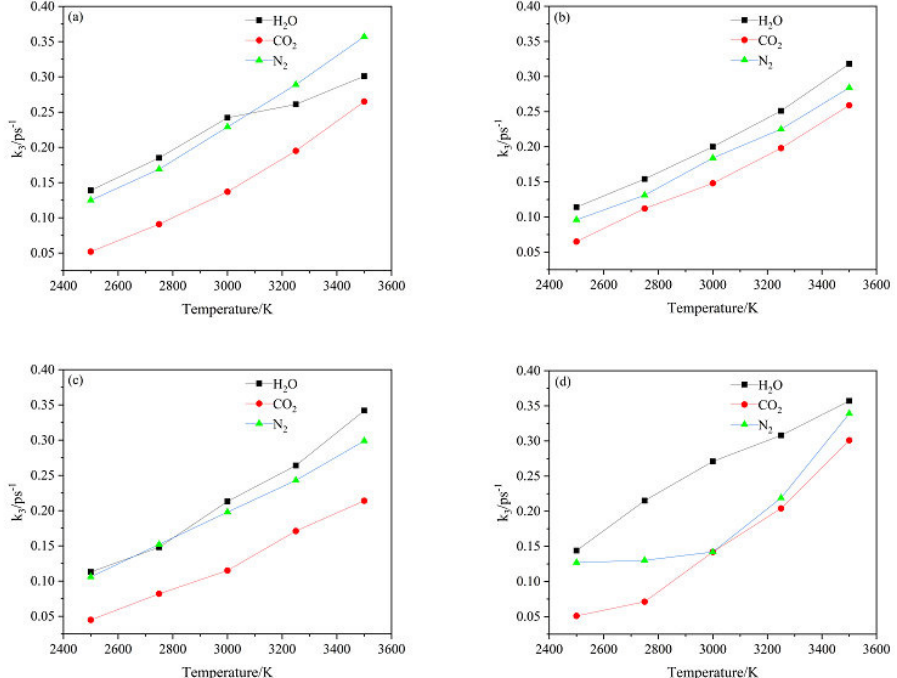
Figure 14. Comparison of the k 3 values of CO 2 , H 2 O and N 2 for ( a ) CL-20/H 2 O, ( b ) CL-20/CO 2 , ( c ) CL-20/N 2 O, ( d ) CL-20/NH 2 OH at different temperatures. Thick trendline corresponds to the actual concentration data of corresponding matching color.